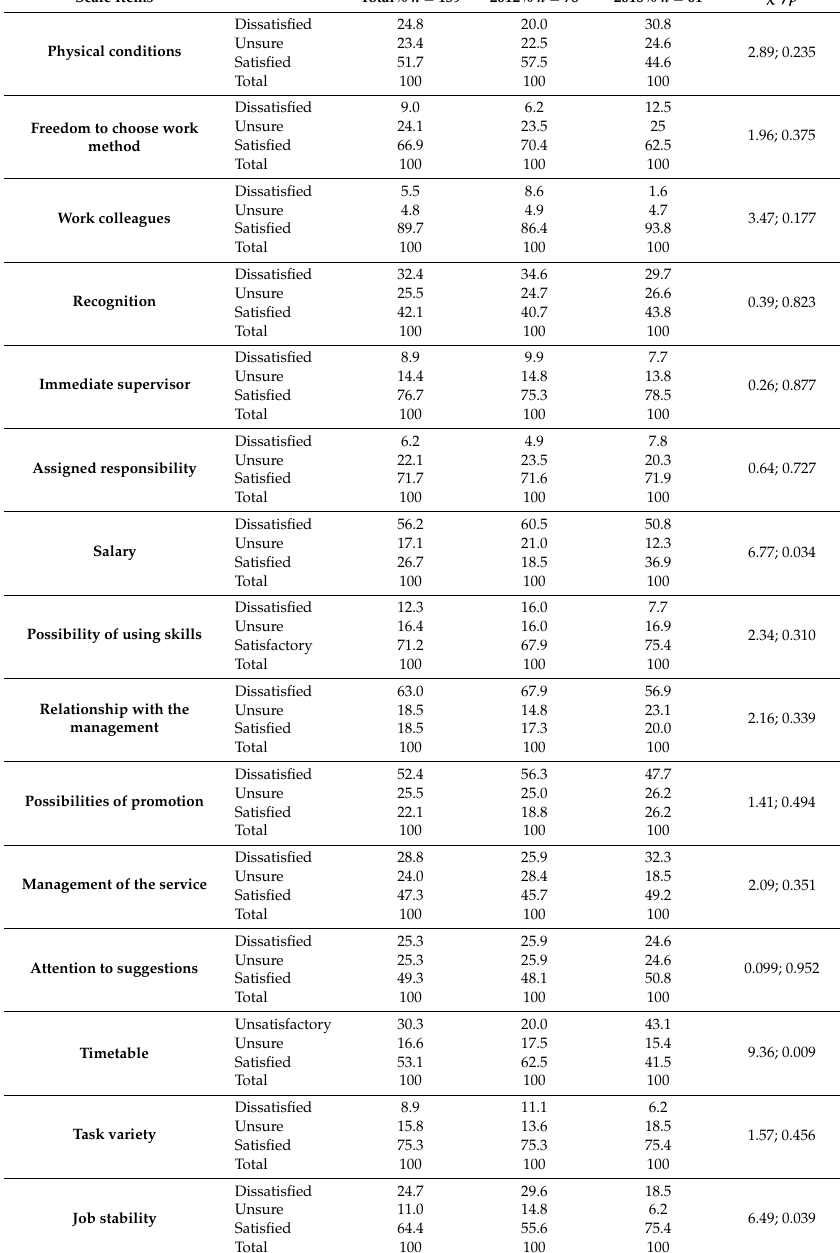
Table 2. Results of the comparison of items of the overall satisfaction scale in 2012 and